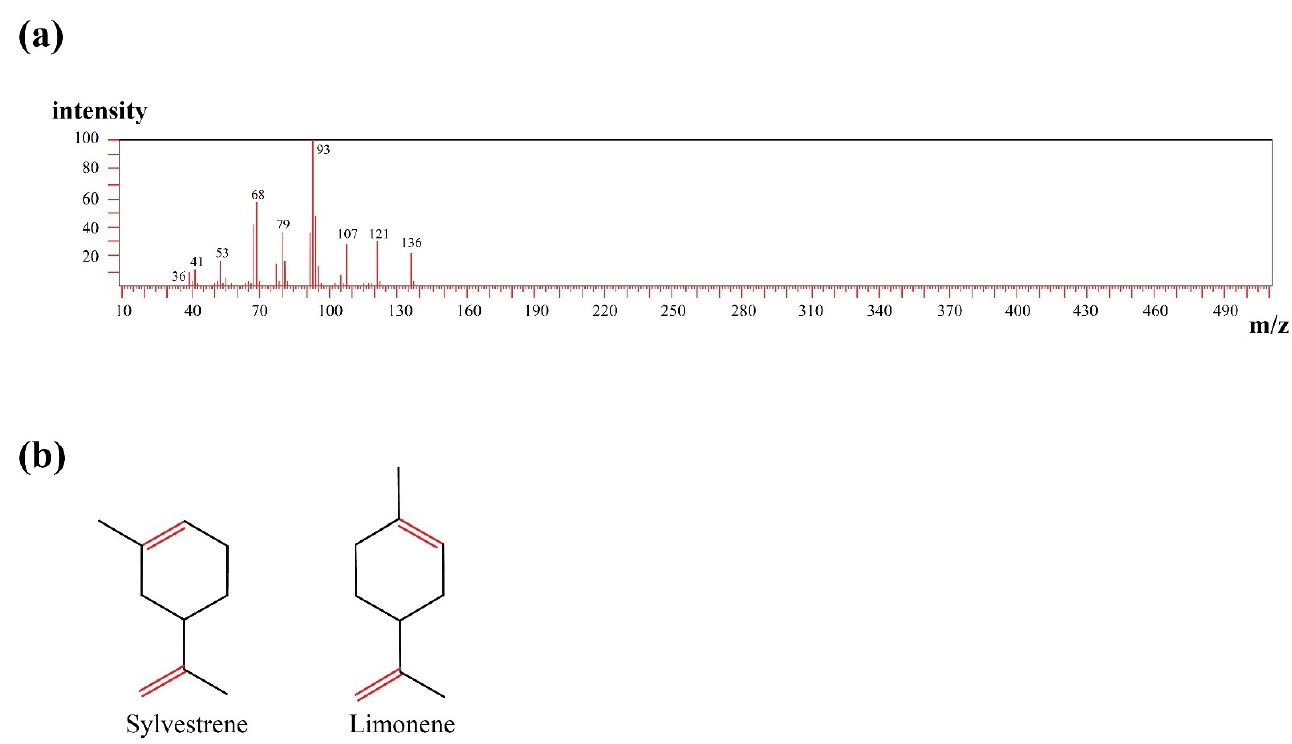
Figure 2. Mass spectrum of sylvestrene in ( a ) and chemical structures of sylvestrene and limonene in ( b ).